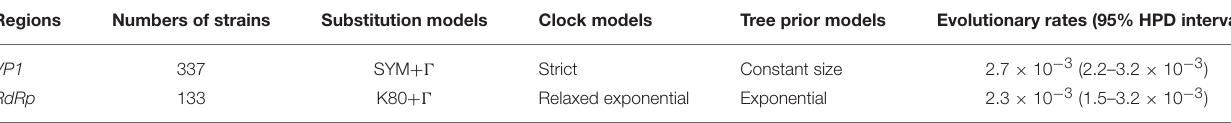
TABLE 1 | Evolutionary rates of GII.P17-GII.17 strains in the VP1 and RdRp regions.